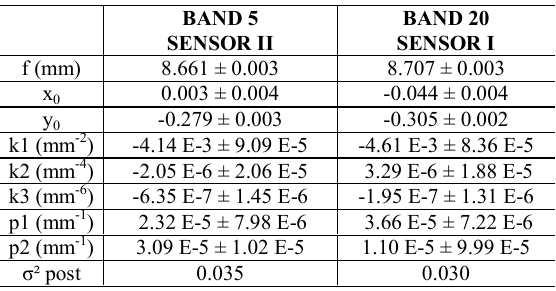
Table 3. Example of two sets of IOPs estimated in the calibration process and respective standard deviations for one band of each sensor.